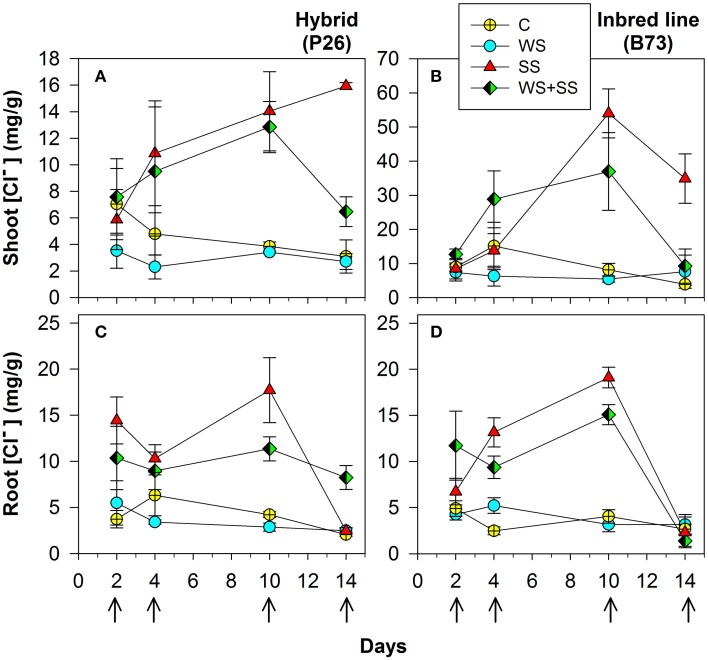
Shoot (A) and (B) and roots (C) and (D) Cl− concentration in maize plantlets of the inbred line B73 and hybrid P26 grown for 10 days under control (C), drought (WS), salinity (SS), or the combination of drought and salinity (WS+SS) and after 4 days of recovery from the stresses. Values represent means ± SE (n = 3). Arrows represent sampling times throughout the experimental period.